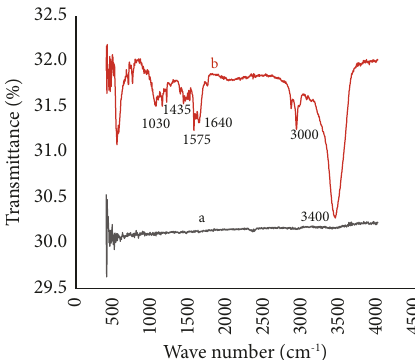
Figure 2: FT-IR spectra of unmodified graphite (a) and HDPBA modified graphite (b).